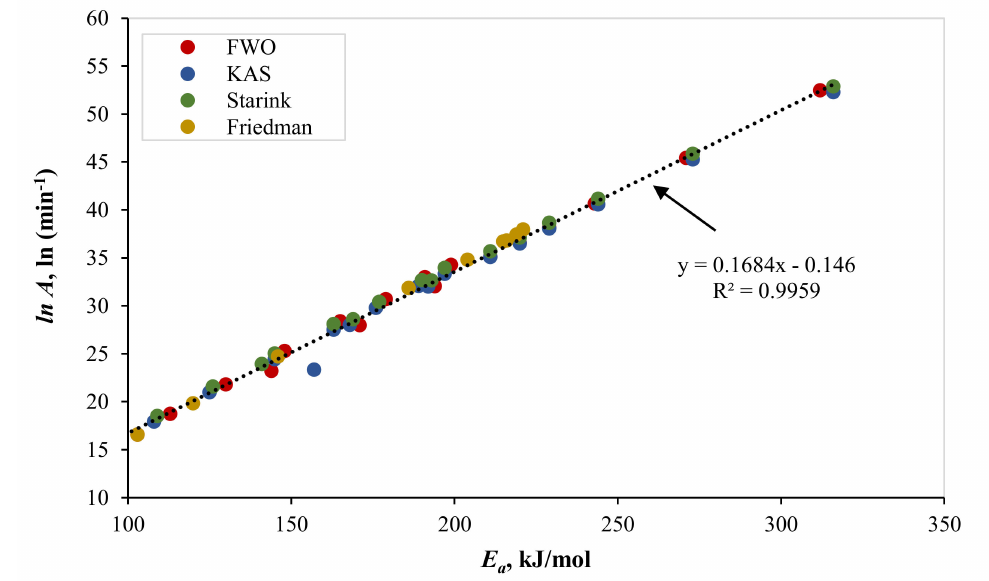
Figure 6. Linear relationship between ln A and Ea